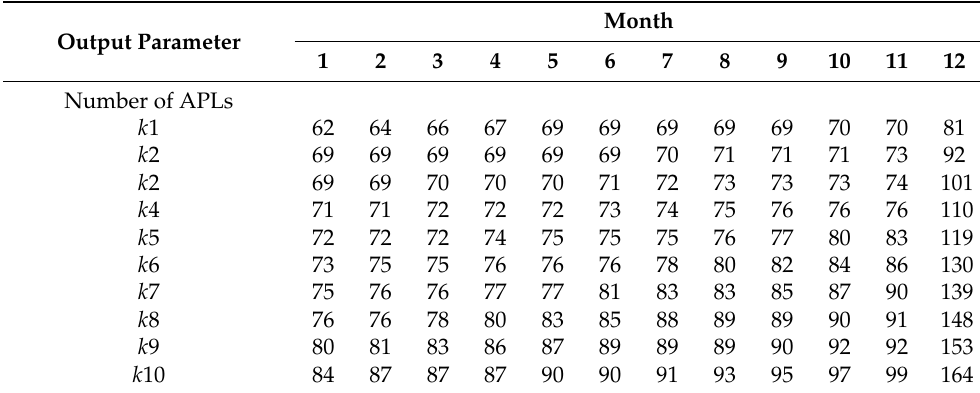
Table A4. Number of APLs in the first year.